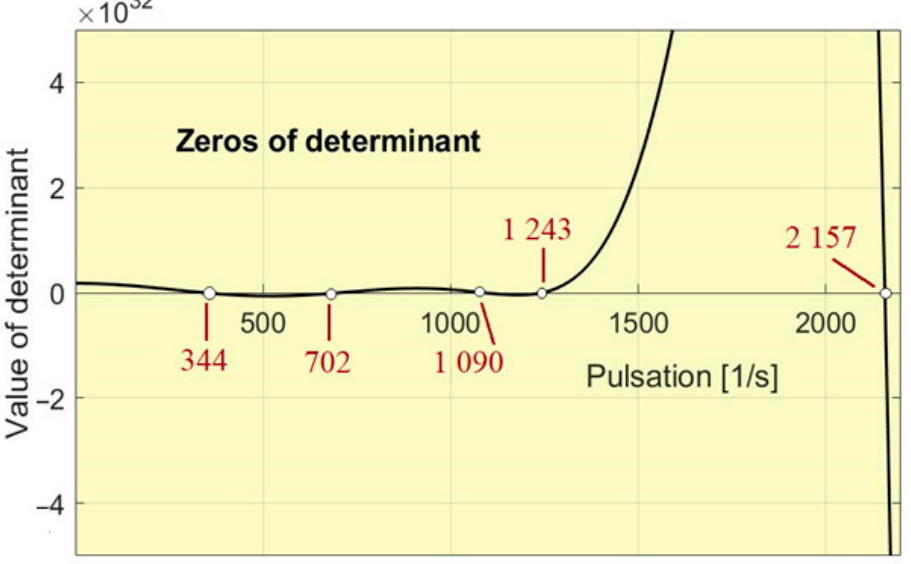
Figure 2. The representation of the function P ( ω ) .